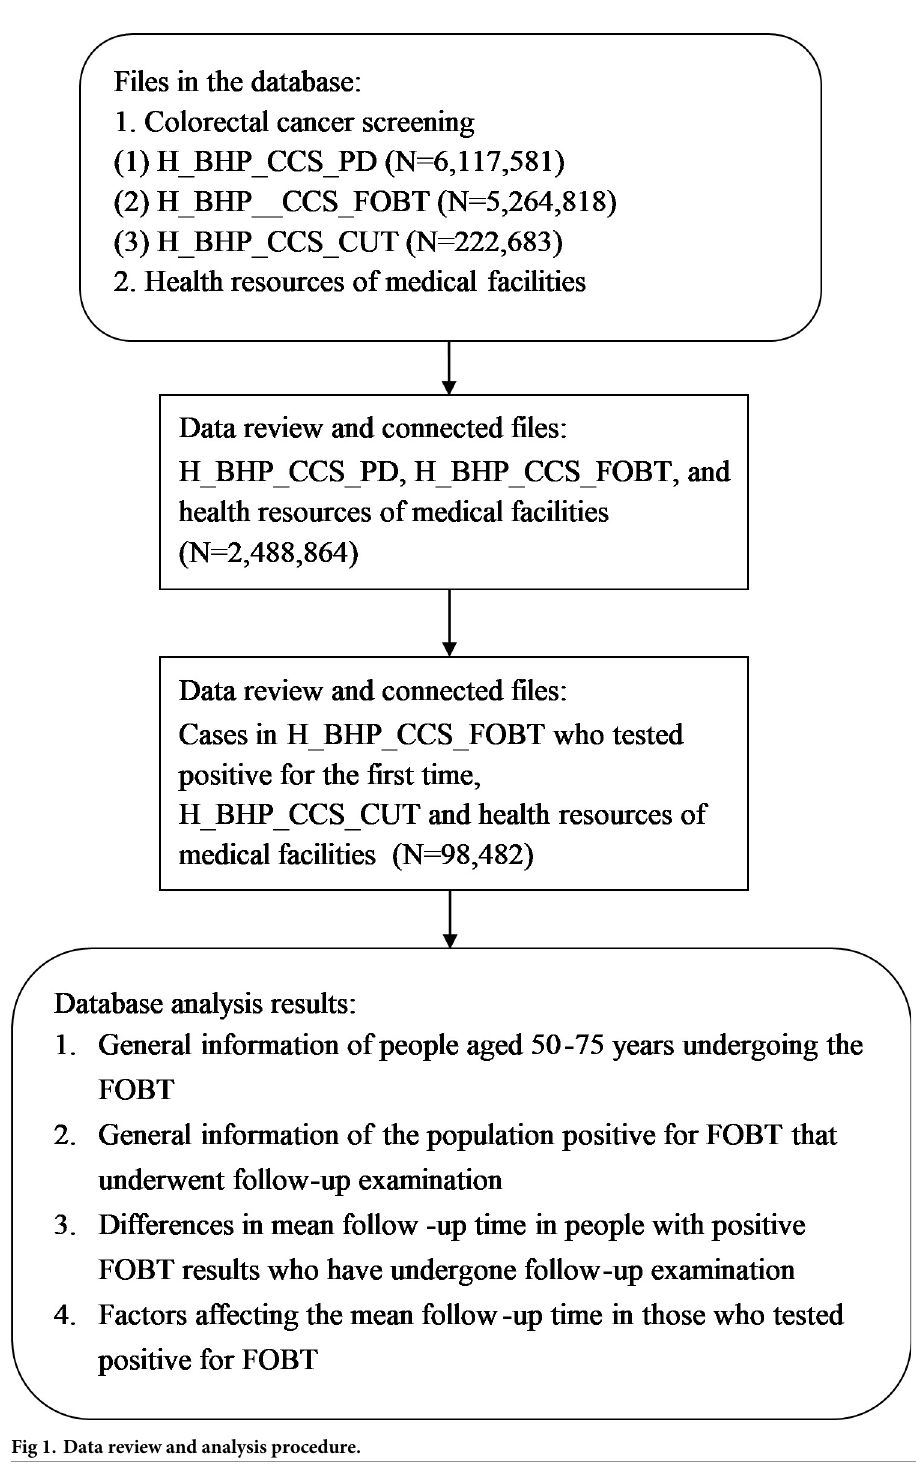
Fig 1. Data review and analysis